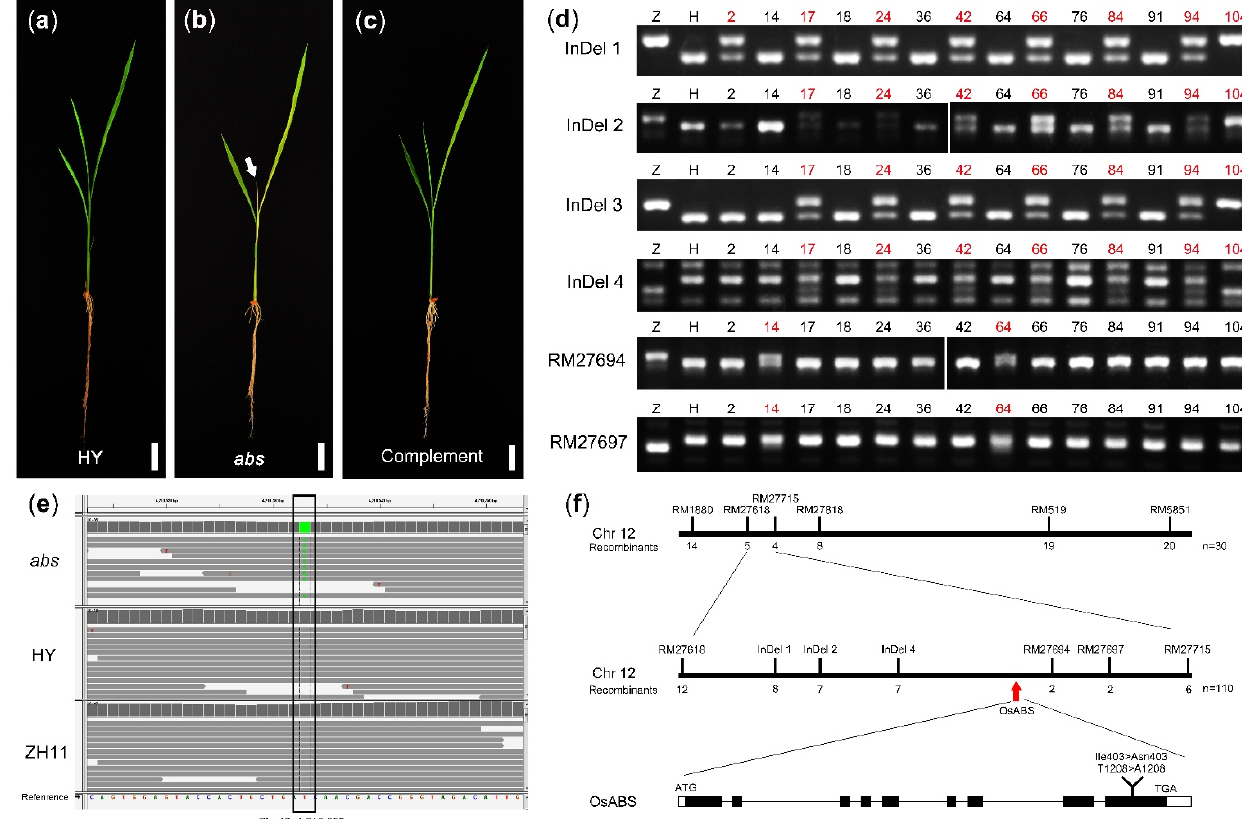
Figure 7. The phenotype of abs and cloning of OsABS gene: ( a ) 14 DAG seedling of Hwayoung (HY); ( b ) 14 DAG seedling of abs . The white arrow indicated the chlorotic fourth leaf; ( c ) 14 DAG complementary seedling of abs . ( d ) The analysis of recombinants around the mutated site in abs . All the plants used here were the recombinants at RM27618 or RM27715, and the red number indicated the recombinant. InDel 1, InDel 2, InDel 3, InDel 4, RM27694 and RM27697 are located around Chr12: 4,070,394 bp, Chr12: 4,187,138 bp, Chr12: 4,400,174 bp, Chr12: 4,403,614 bp, Chr12: 4,814,750 bp and Chr12: 4,920,770 bp, respectively. Z, Zhonghua 11; H, Hwayoung. ( e ) The whole-genome sequencing results at the mutated site in abs, HY and ZH11 using the IGV software. A thymine (Chr12: 4,710,533 bp, indicated in the black box) was converted to adenine. ( f ) The cloning procedure of OsABS. Bars were 2 cm in ( a – c